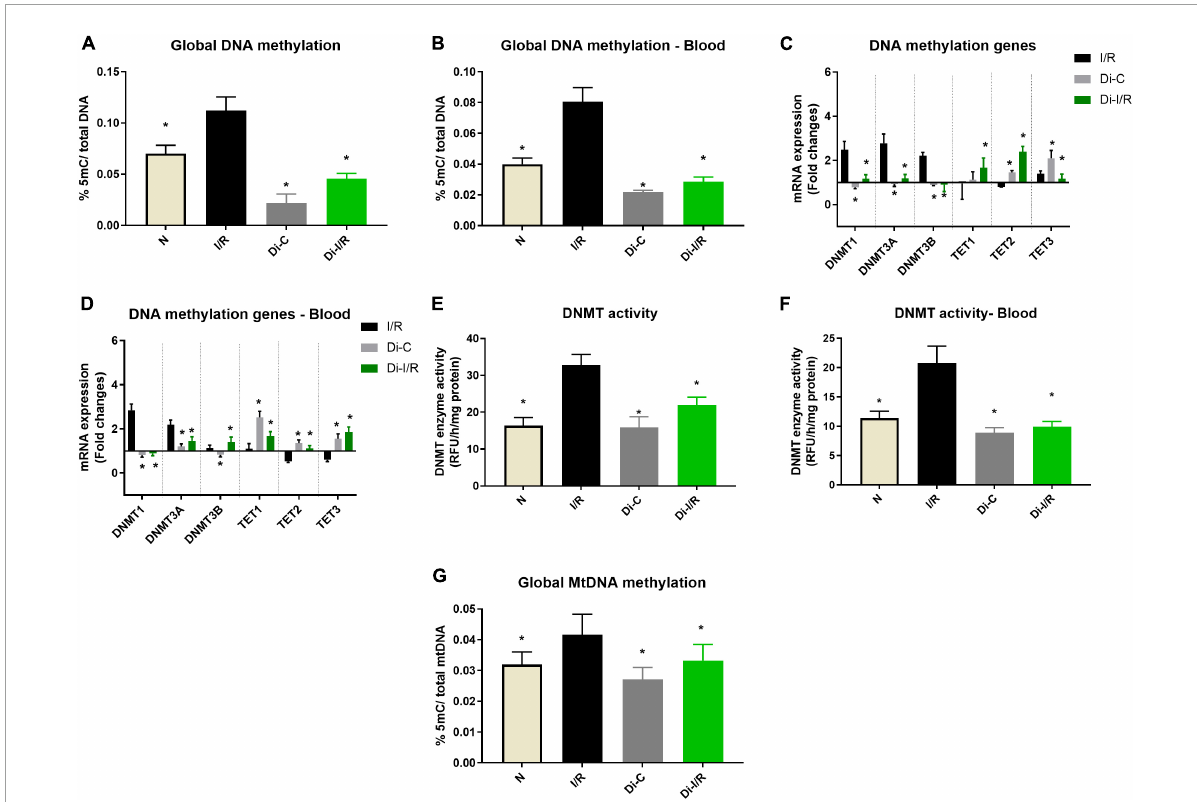
FIGURE1 Ischemia reperfusion (I/R) induced DNA methylation changes in the myocardium and blood in LAD model. Methylation changes induced by I/R were assessed from (A) %5-mC in cardiac DNA; (B) %5-mC in blood DNA; (C) DNMT and TET gene expression in the myocardium; (D) Blood DNMT and TET gene expression; (E) Myocardial DNMT activity; (F) DNMT activity in blood; (G) mtDNA methylation in the myocardium. The graphs represent mean ± SD values. The changes in gene expression are represented as fold changes from the normal group. * p < 0.05 vs.